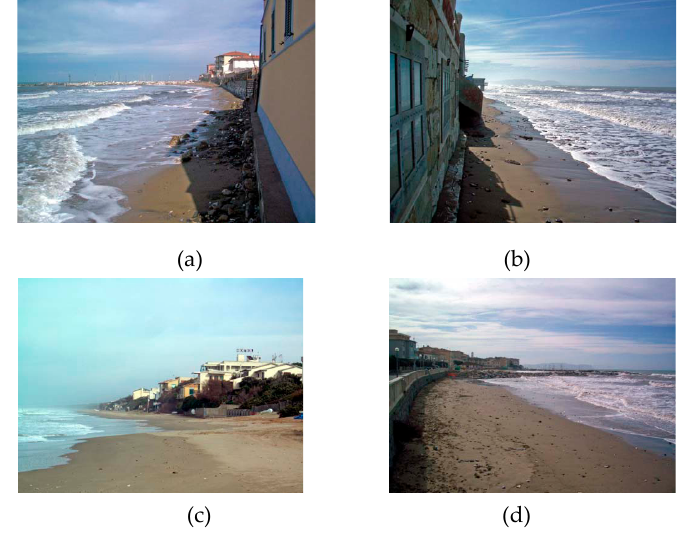
Figure 4. San Vincenzo shore at the start of reshaping works on the harbor (04/03/2006). (a–b) South harbor area; (c–d) North harbor area [40].